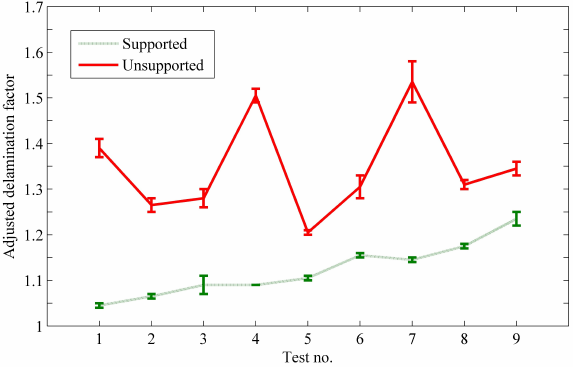
Figure 5. Comparison of F without